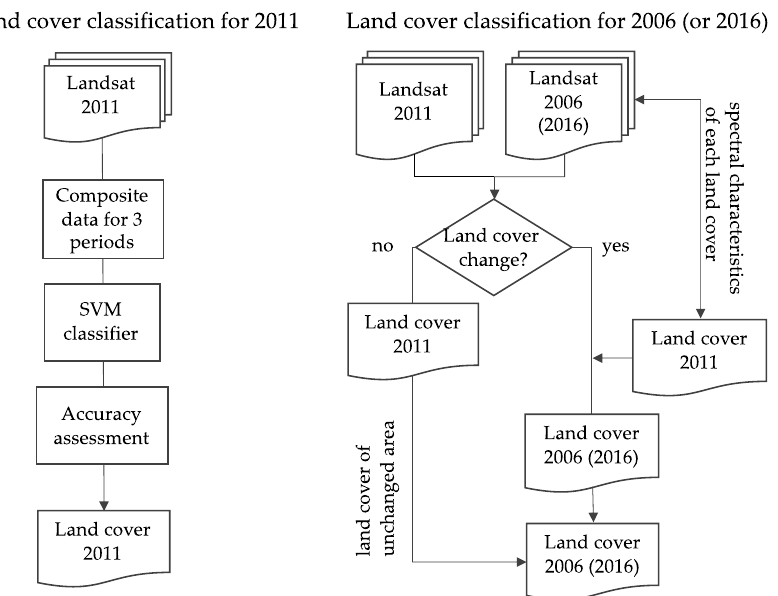
Figure 2. Land cover classification flowchart.